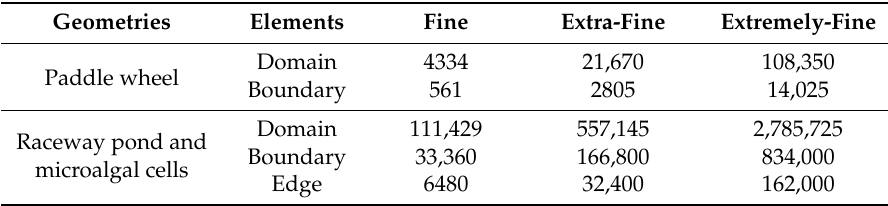
Figure 2. Grid independency test using ( a ) water velocity (m/s) and ( b ) cell wall deformation (nm). Table 2. Mesh elements of the paddle wheel, raceway pond, and microalgal